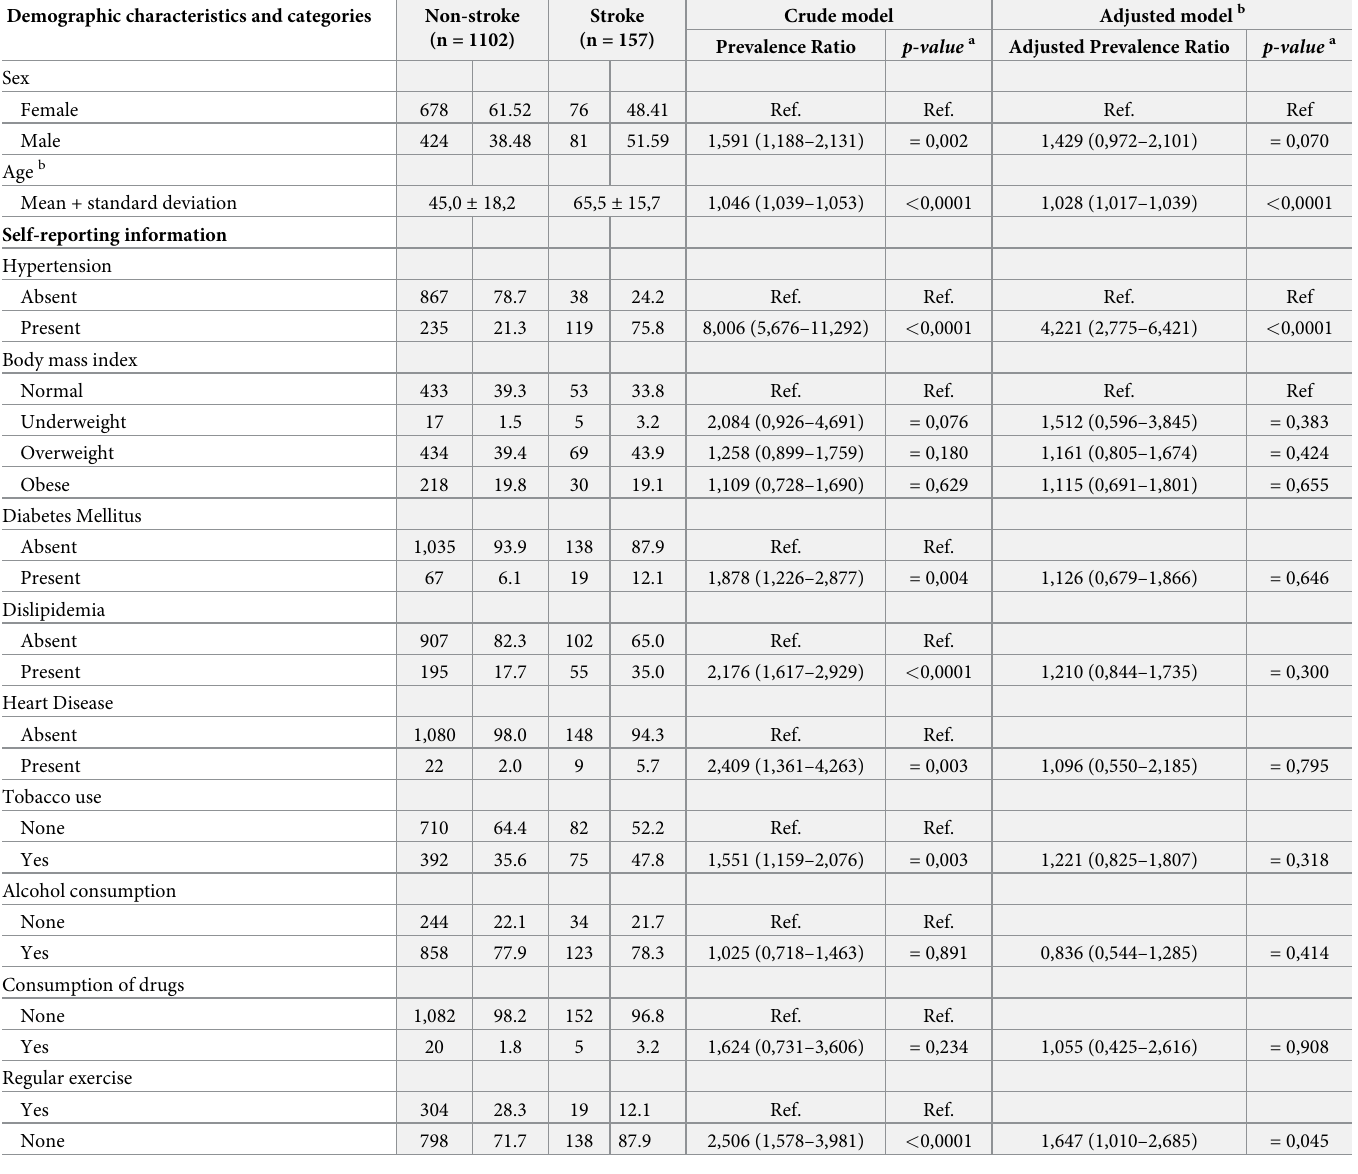
Table 3. Self reported information about cardiovascular health between stroke cases and non-stroke cases. Demographic characteristics and